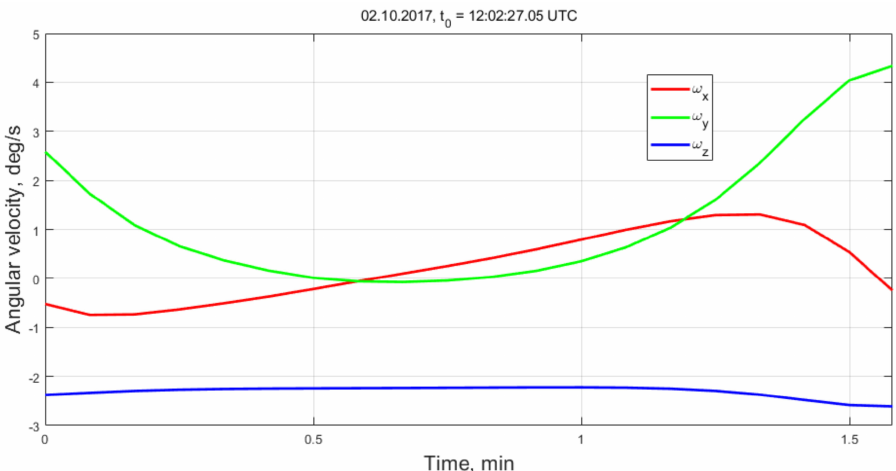
Figure 19. Angular velocity in the body reference